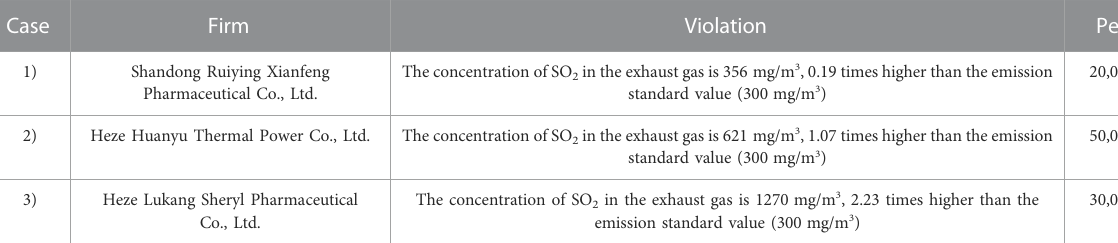
TABLE 1 Cases of environmental administrative penalties in Heze City in 2013 2 .